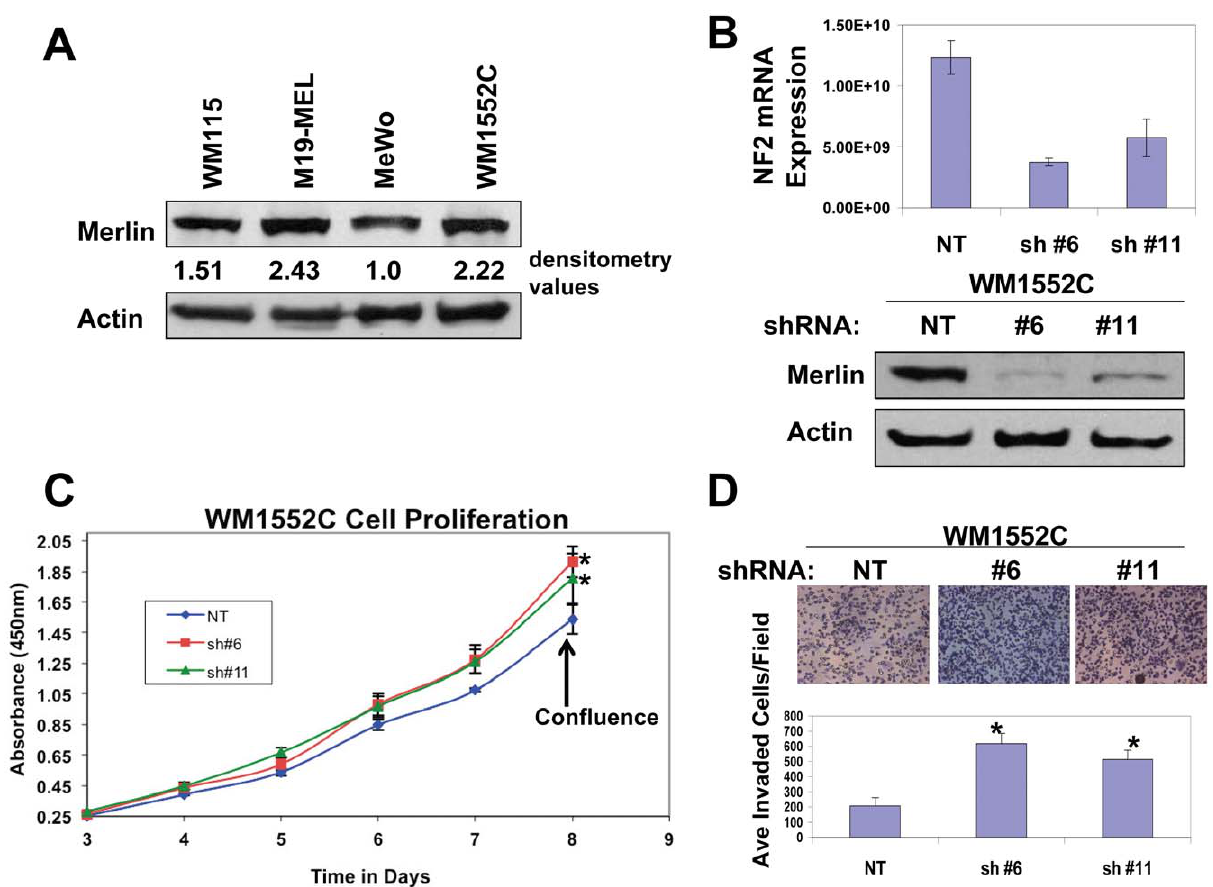
Figure 1. Merlin knockdown promotes proliferation and invasiveness of WM1552C human melanoma cells. A , Western blot analysis of endogenous merlin expression in human melanoma cell lines. Actin was used as a loading control. 50 m g of protein were loaded in each lane. Numbers are densitometry values used to normalize merlin expression to actin loading controls. B , Top Panel, Real-time-RT-PCR to assess the merlin mRNA levels in WM1552C cells transduced with non-targeting (NT) or merlin shRNA ( # 6 and # 11). Bottom Panel, Western blot analysis of merlin protein levels in WM1552C cells transduced with the non targeting shRNA (NT) or shRNA targeting human NF2 (sh # 6 and sh # 11). Actin was used as a loading control. 50 m g of protein were loaded in each lane. C , WST-1 Proliferation assays of the transduced WM1552C cells. *denotes a p -value , 0.05. D , Matrigel invasion assays of the transduced WM1552C cells. Bars represent the mean invaded cells in 15 randomly selected 200X microscopic fields + / 2 SD. *denotes a p -value , 0.01.